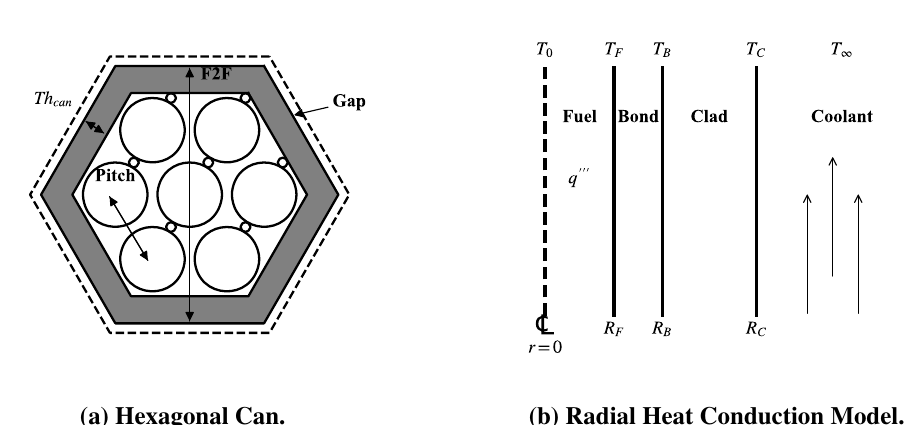
Figure 1: Thermal Hydraulics Geometric Descriptions (not to scale).